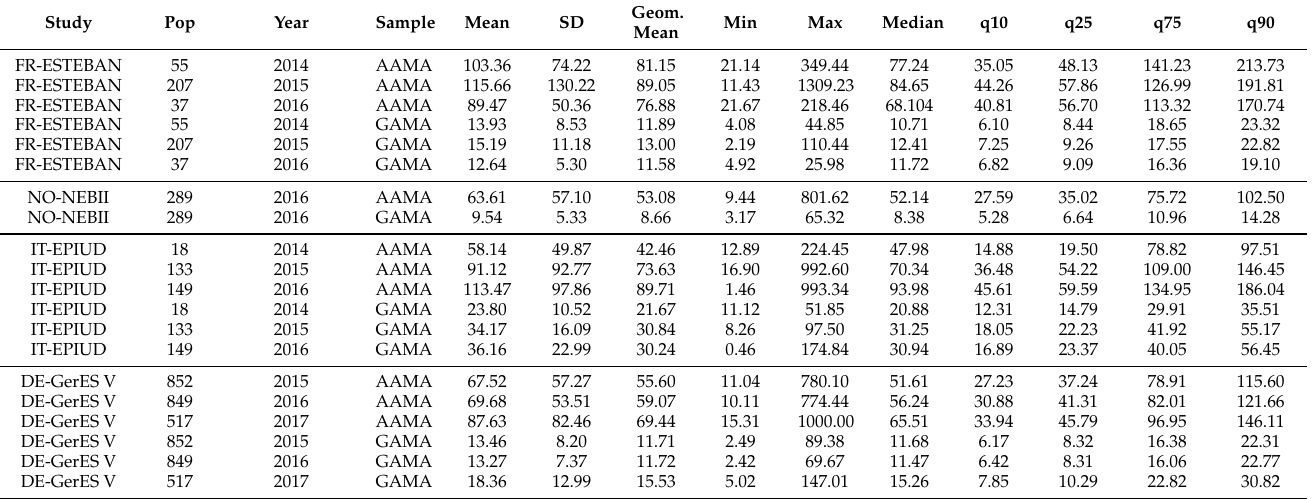
Table A6. Descriptive statistics of acrylamide biomarker levels per study and year (children and teenagers).